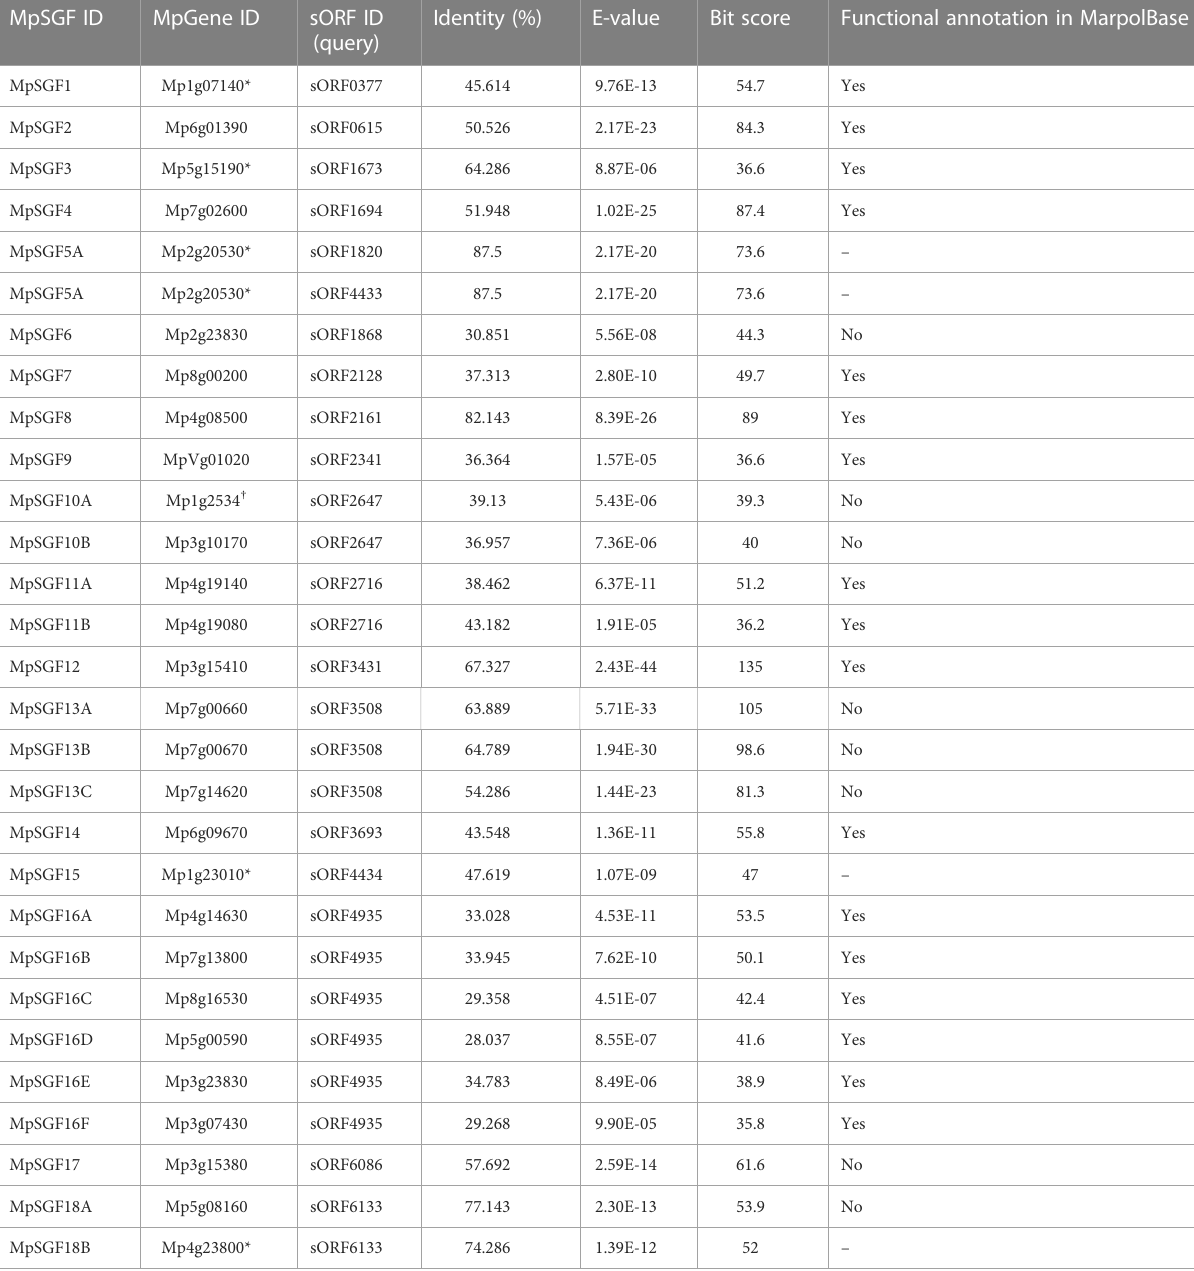
TABLE 1 A list of MpSGFs, containing BLAST results and annotations registered in the database